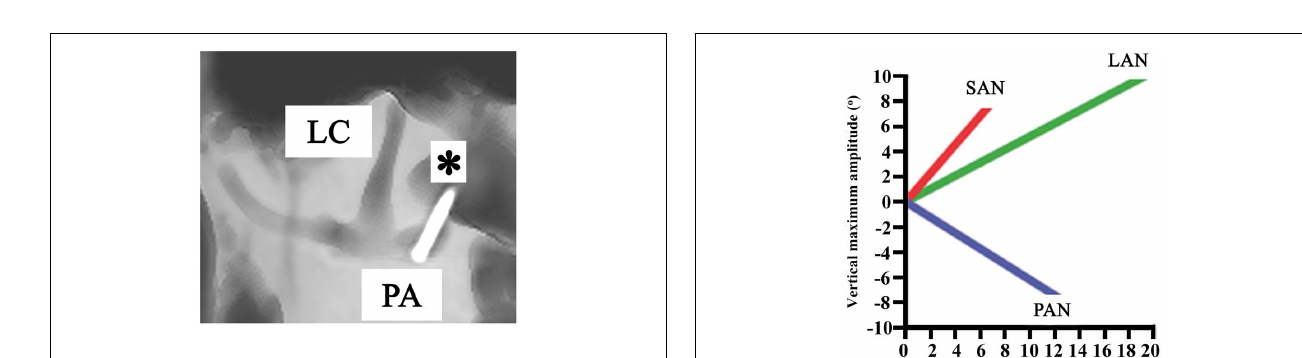
FIGURE 3 |Anterolateral view of a right temporal bone using cone beam CT-scan. It shows the fenestration and insertion of the electrode ( ∗ ) in the posterior ampulla (PA). (LC = lateral canal).